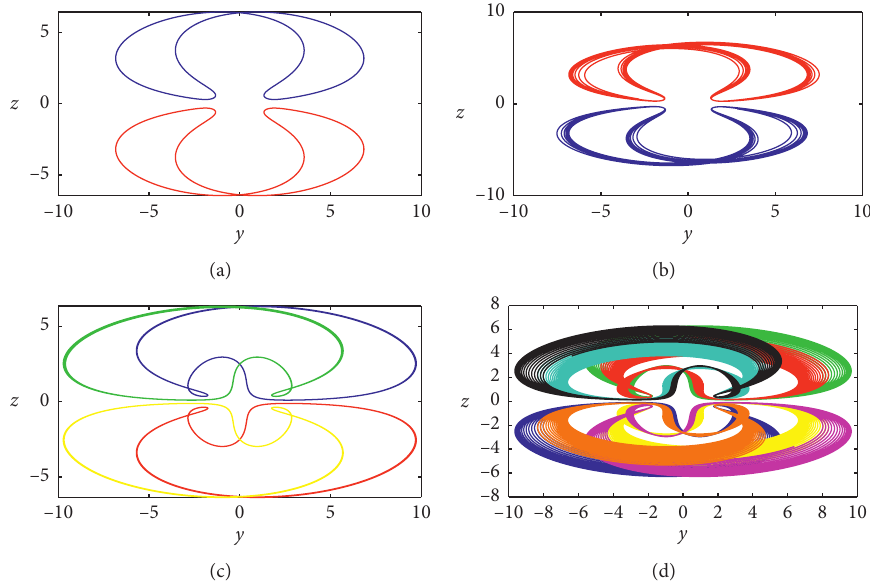
Figure 7: Coexisting attractors in the memristive hyperchaotic system: projections of different attractors on the y − z plane for different initial conditions. (a) Symmetric two-wing period-1, [ 1 , 1 , 1 , 1 , 1 , 1 ] (blue) and [ 1 , − 1 , − 1 , 1 , − 1 , 1 ] (red). (b) Symmetric two-wing mul- tiperiod, [− 1 , 1 , 1 , 1 , 1 , − 1 ] (red) and [− 1 , − 1 , − 1 , − 1 , − 1 , 1 ] (blue). (c) Symmetric one-wing period-1, [− 1 , − 1 , − 1 , − 1 , − 1 , − 1 ] (red), [− 1 , 1 , 1 , 1 , 1 , 1 ] (blue), [ 1 , 1 , 1 , − 1 , − 1 , 1 ] (green), and [− 1 , 1 , − 1 , − 1 , − 1 , − 1 ] (yellow). (d) Symmetric one-wing